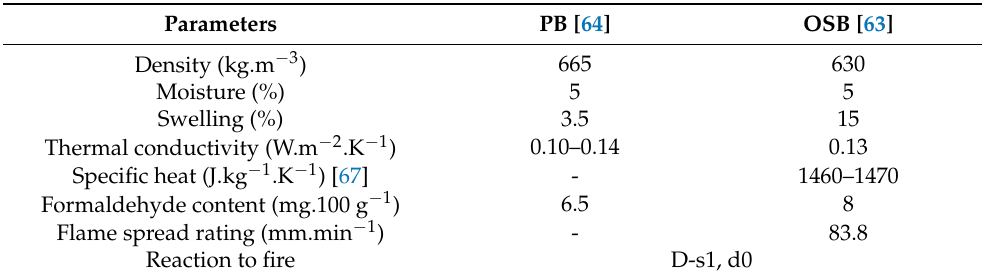
Table 2. Physical and chemical properties and fire-technical characteristics of particleboards and OSB with thicknesses of 10–18 mm.